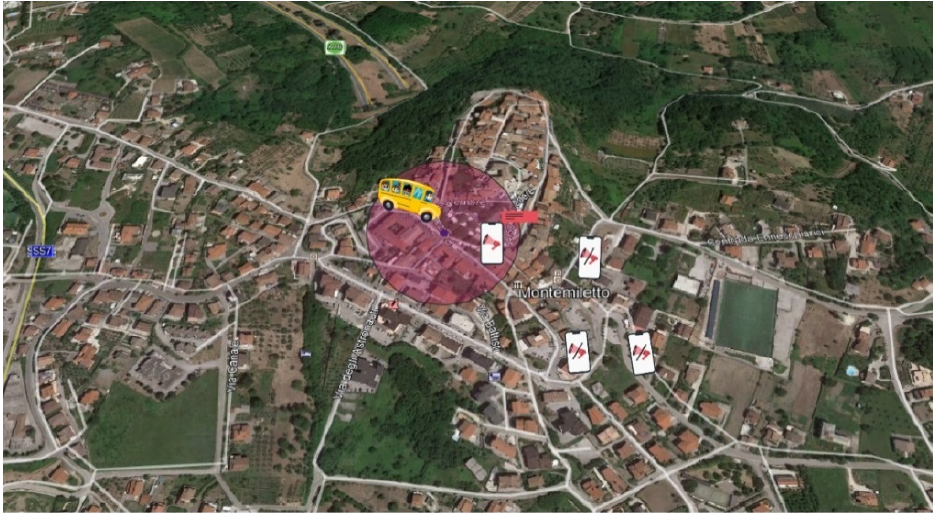
Figure 1. A geo-social service in SAfety for Families in Emergency (SAFE).